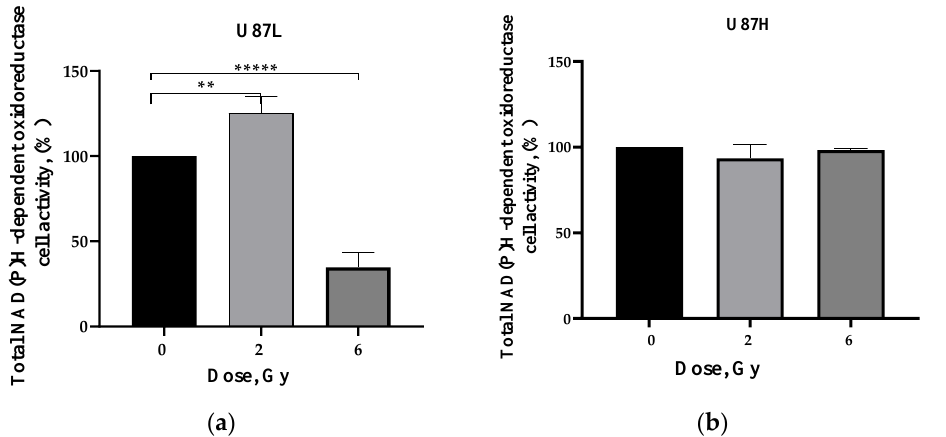
Figure 2. Assessment of the metabolic activity of U87L ( a ) and U87H ( b ) cells 7 days after irradiation at doses of 2 and 6 Gy using the Alamar Blue test in soft agar. ** p < 0.01; ***** p < 0.00001.